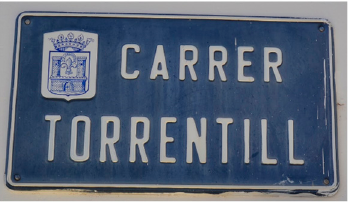
Figure 8. Benasal: Valencian-only street name .